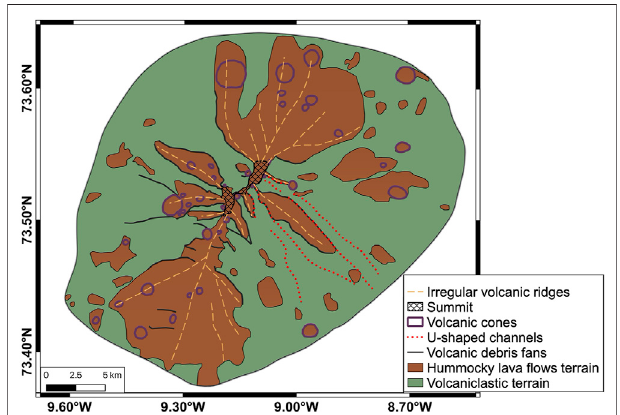
FIGURE 4 | Geological map of the Vesteris Seamount. Criteria for distinguishing between the different structures and units mapped, are provided in Table 1 .